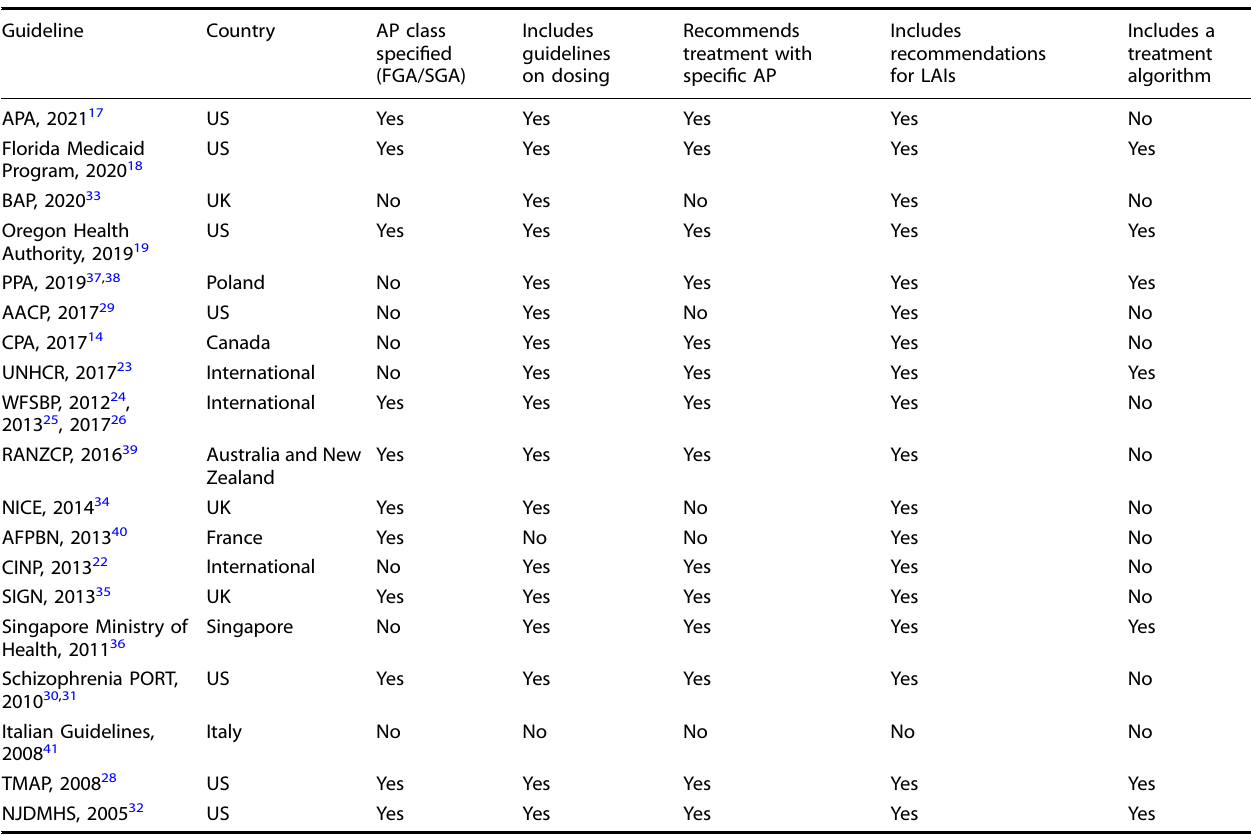
Table 2. Characteristics of schizophrenia